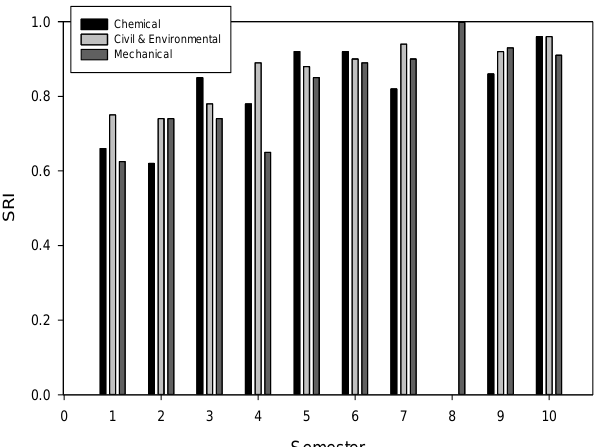
Figure 4. Relaxation index for each semester in the study plan for the Chemical, Civil & Environmental,